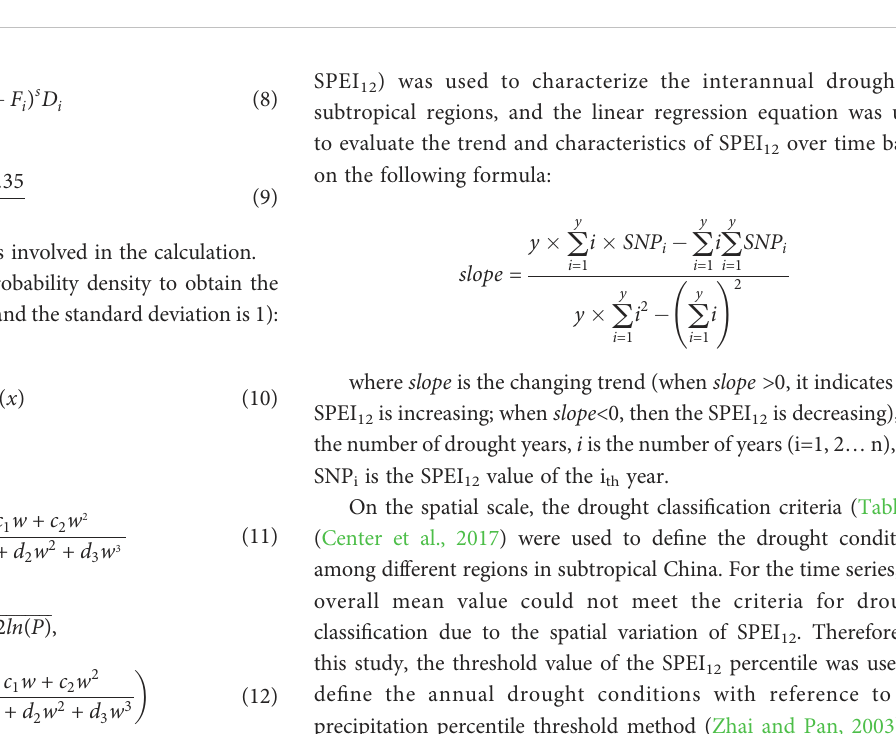
FIGURE 2 The percentage of clay (A) , silt (B) , and sand (C) of subtropical